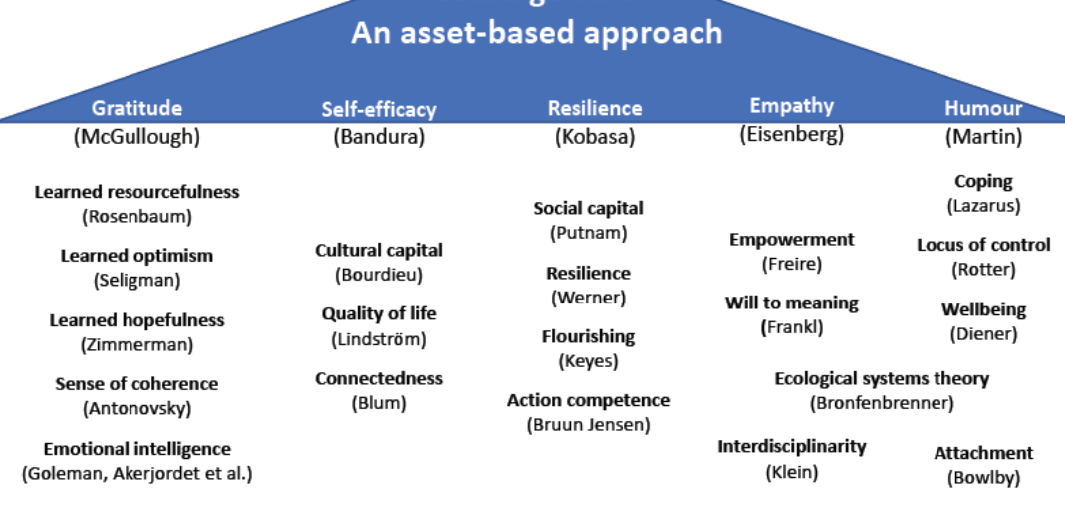
Figure 1. The concepts and theories of salutogenesis. Source: Own illustration, based on [6,16]. In their articles, Lindström and Eriksson organised the various concepts, theories and models under five headings, four of which are briefly described below. As the main focus of this paper is on resilience, it is discussed in more detail in Section 2.3.